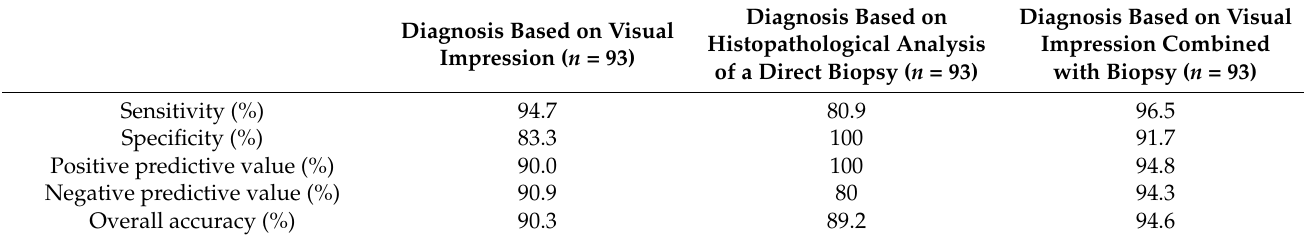
Table 4. Diagnostic yields of visualization by Spy DS and histopathological analysis of direct biopsies.